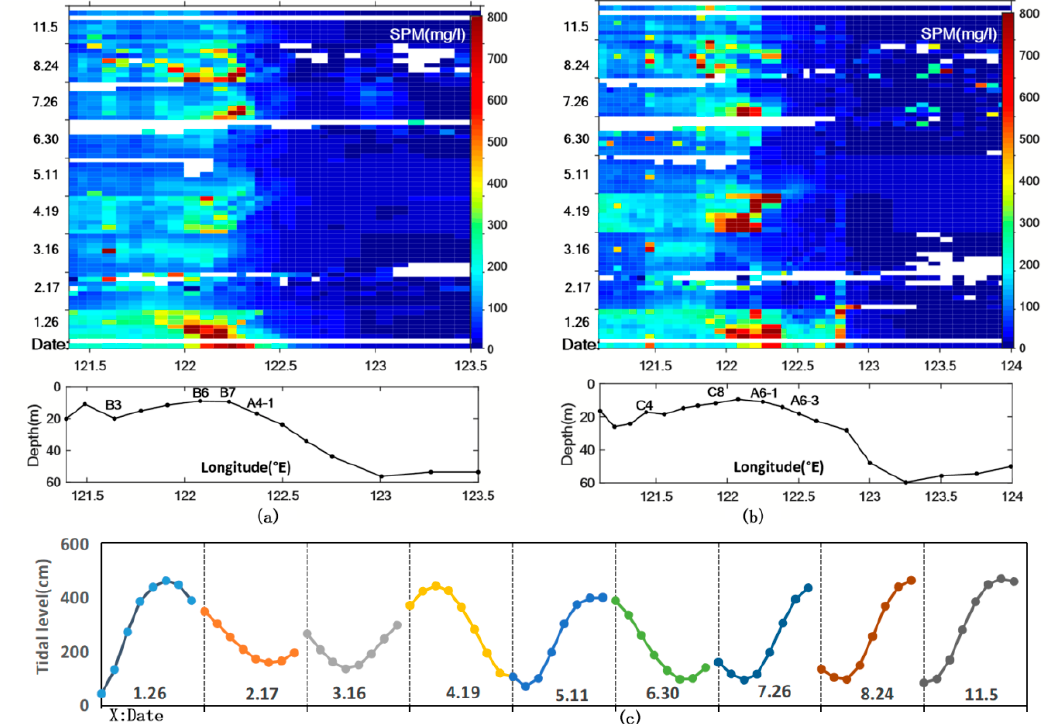
Figure 8. The SPM diurnal variation along two transects in the Changjiang Estuary computed by GOCI on 26 January, 17 February, 16 March, 19 April, 11 May, 30 June, 26 July, 24 August and 5 November 2016 separately. ( a ) Longitude-time plots of SPM concentration from B1 to A4-6. ( b ) longitude-time plots of SPM concentration from C1 to A6-11. ( c ) Tidal elevation measured by Luchaogang gauge at the corresponding imaging time.